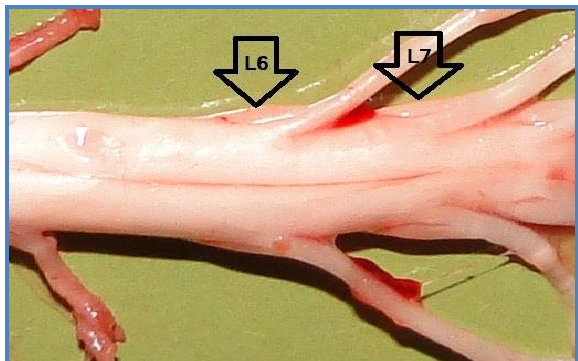
Figure, 1: Lumber segments of rabbit spinal cord with their associated dorsal root ganglia L6 and